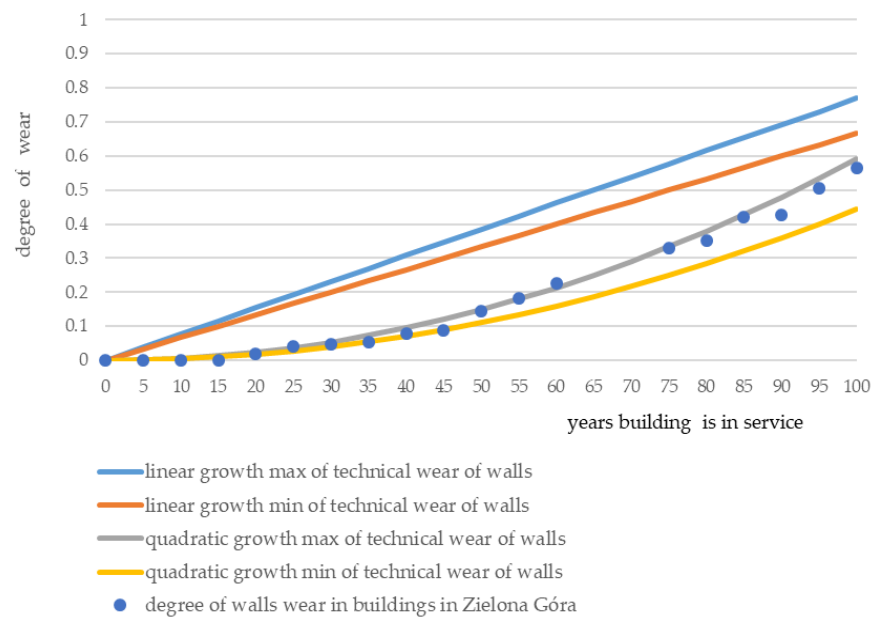
Figure 2. Predictions of the degree of wear of masonry walls as well as values of the degree of wall wear resulting from the periodic inspection of buildings located in Zielona Góra.